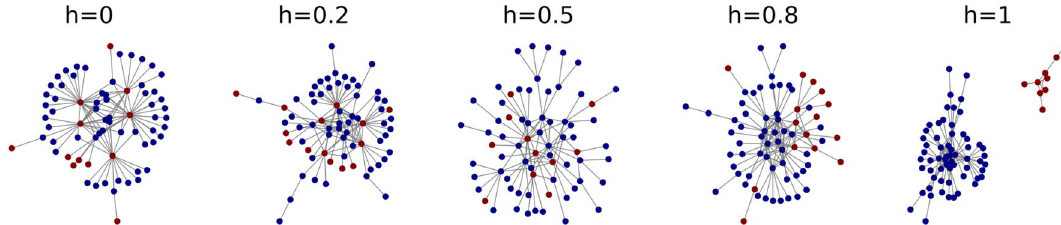
Figure 1. Topology of the networks generated by the BAh model, for different values of the homophily parameter h . Blue nodes indicate a majority group, while red nodes indicate a minority group. Other parameters: number of nodes N = 70 , BAh parameter m = 1 , minority fraction f a = 0.2